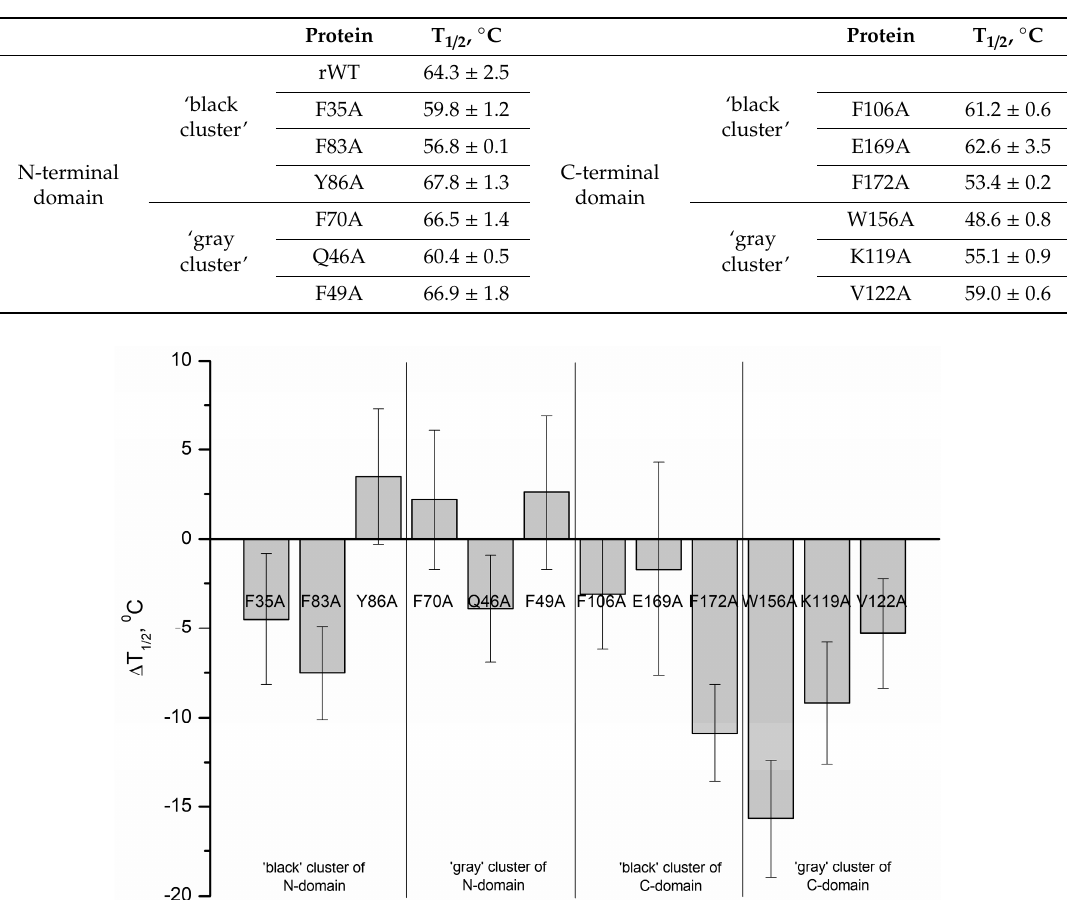
Figure 5. Effects of alanine substitutions in the ‘black’ and ‘gray’ clusters of rWT human recoverin on mid-temperature of its thermal transition in apo-state.